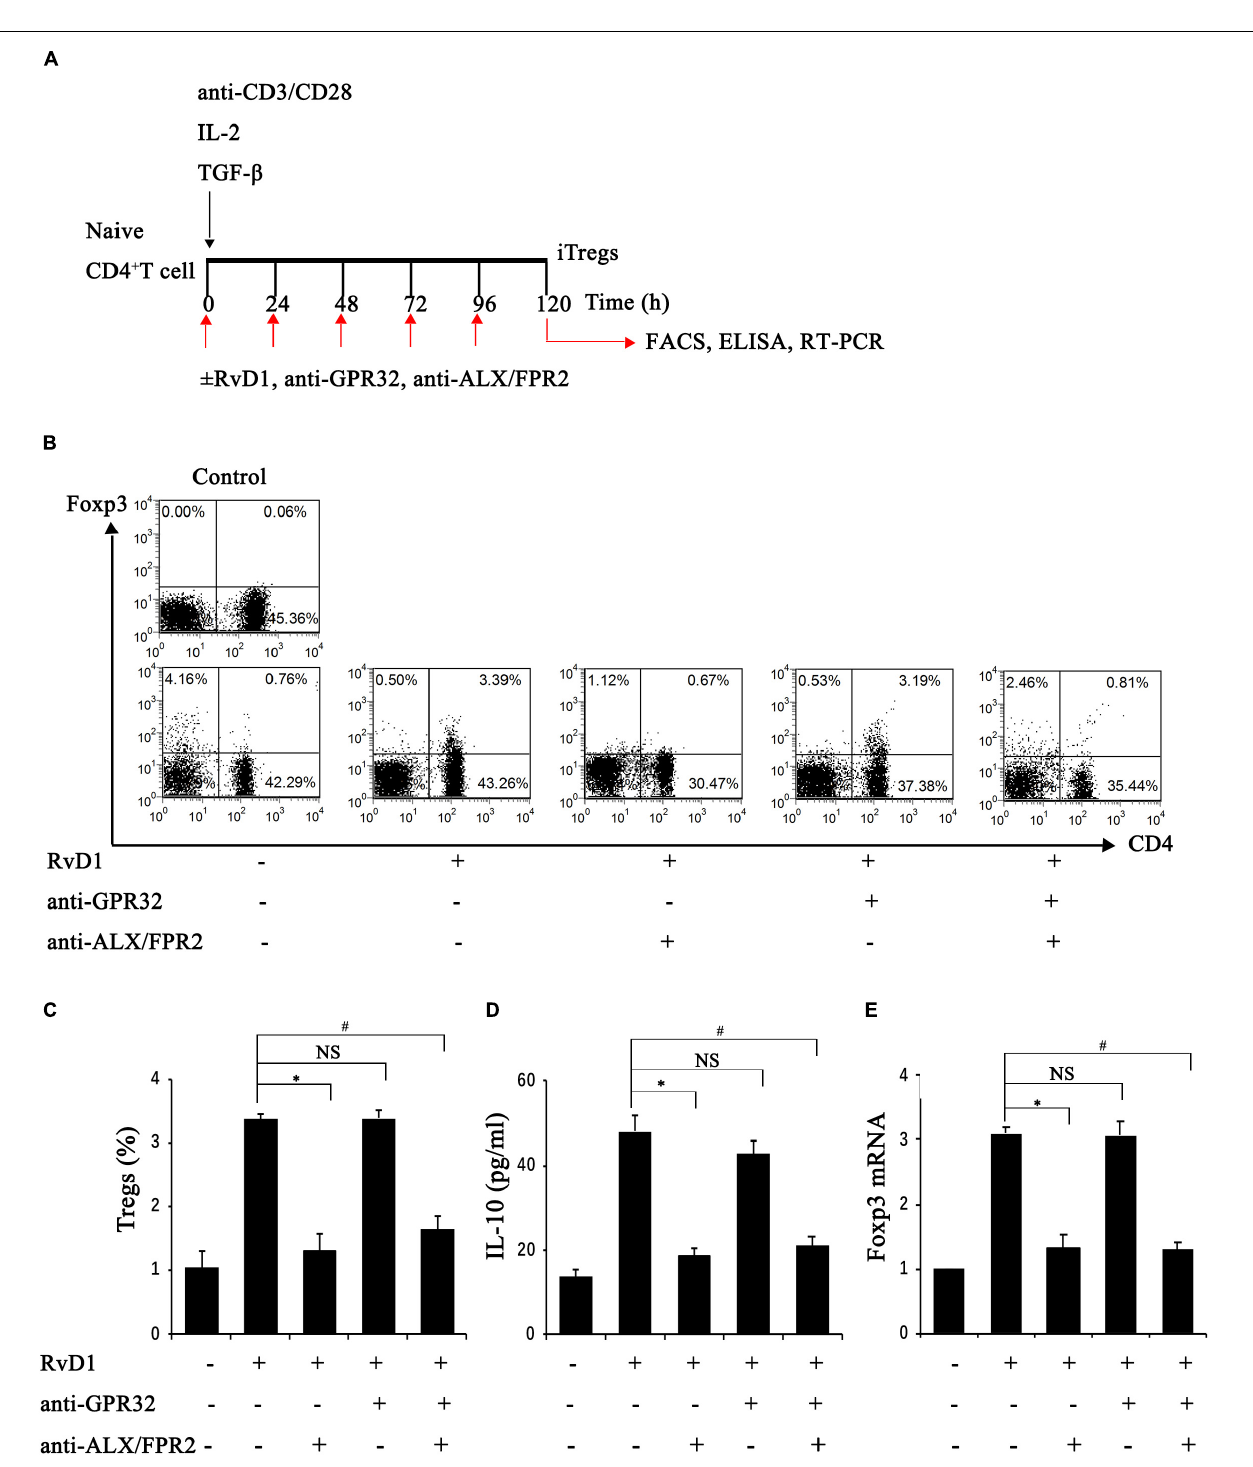
FIGURE 5 | RvD1 induced the generation of iTregs via the receptor ALX/FPR2. (A) The sketch map of iTreg generation. (B) Representative flow cytometry analysis of iTregs generated with or without RvD1, an anti-GPR32 neutralizing antibody, or an anti-ALX/FPR2 neutralizing antibody at 96 h after incubation under the condition of iTreg generation. The plots are gated for CD4 + lymphocytes. The data are representative of 3 independent experiments. (C) The percentage of iTregs. (D) IL-10 levels in the supernatants of iTregs as determined by ELISA. (E) The mRNA expression of Foxp3 in iTregs as determined by RT-PCR. Values are expressed as the means ± SDs, n = 6 per group. ∗ P < 0.05, RvD1 versus RvD1 + anti-ALX/FPR2 antibody; # P < 0.05, RvD1 versus RvD1 + anti-ALX/FPR2 antibody + anti-GPR32 antibody; NS: not significant, RvD1 versus RvD1 + anti-GPR32 antibody.